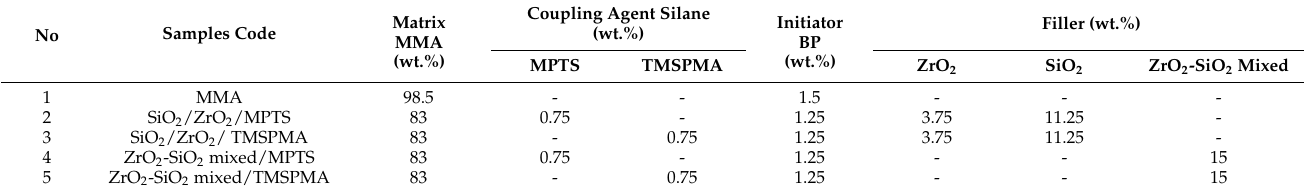
Table 1. Experimental setup of the composite samples in comparison with only MMA.